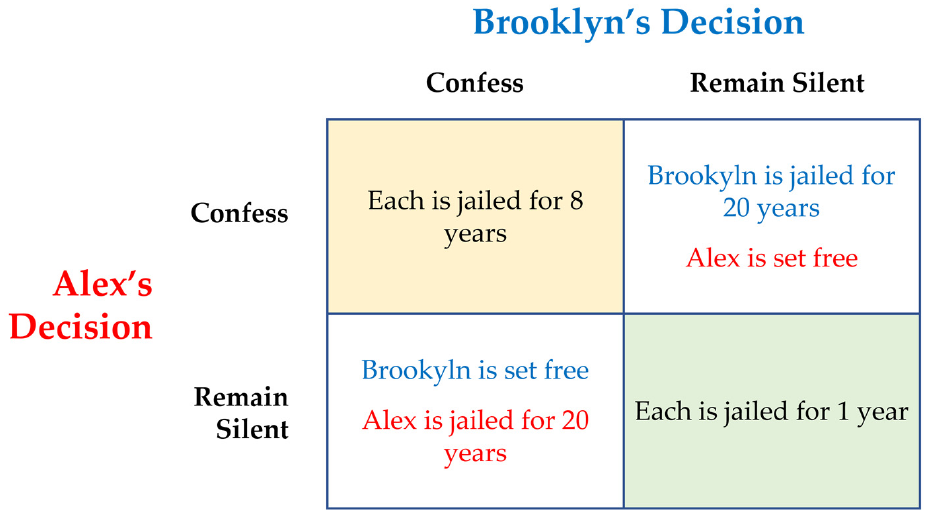
Figure 2. The choices and payoffs for the two criminals.